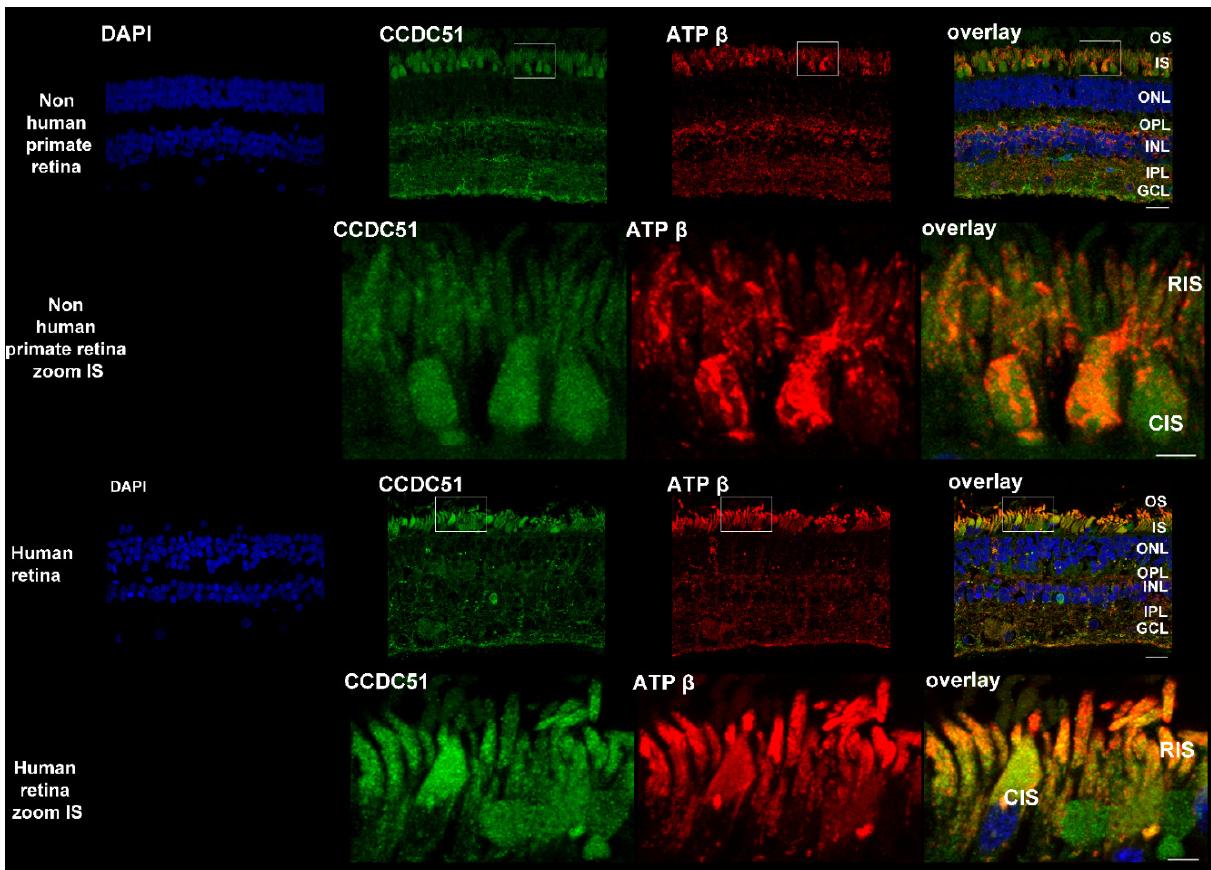
Figure 5. Detection of CCDC51 in the retina of non-human primate and human. Top: A non-human primate retinal section showed CCDC51 immunolocalization with the anti-CCDC51 antibody in different retinal cell layers (green and yellow). A similar staining with the mitochondrial mouse anti-ATP synthase subunit beta antibody (red and overlay) was obtained (bar = 20 μ m). The enlarged image showed that the CCDC51 and ATP synthase subunit beta staining was found in close proximity, with some overlap in the inner segment of both rod and cone photoreceptor cells (zoom, green, and red and yellow, respectively). Nuclei were stained with DAPI (blue) (bar = 5 μ m). Middle: A human retinal section showed CCDC51 immunolocalization with the validated rabbit anti-CCDC51 antibody in different retinal layers (green and yellow). A similar staining with the mitochondrial mouse anti-ATP synthase subunit beta antibody (red and overlay) was obtained (bar = 20 μ m). The enlarged images showed that the CCDC51 and ATP synthase subunit beta staining was found in close proximity, with some overlap in the inner segment of both rod and cone photoreceptor cells (zoom, green, red, and yellow, respectively). Nuclei were stained with DAPI (blue) (bar = 5 μ m). OS = outer segment, IS = inner segment, CIS = cone inner segment, RIS = rod inner segment, ONL = outer nuclear layer, OPL = outer plexiform layer, INL = inner nuclear layer, IPL = inner plexiform layer, GCL = ganglion cell layer.